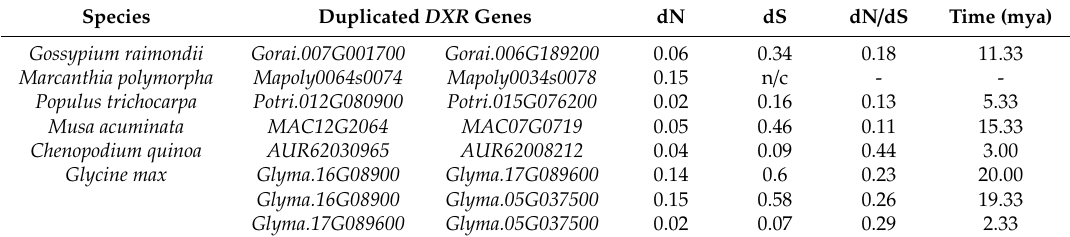
Table 5. Duplication time estimated by dN / dS analysis for DXR genes in six plant species.